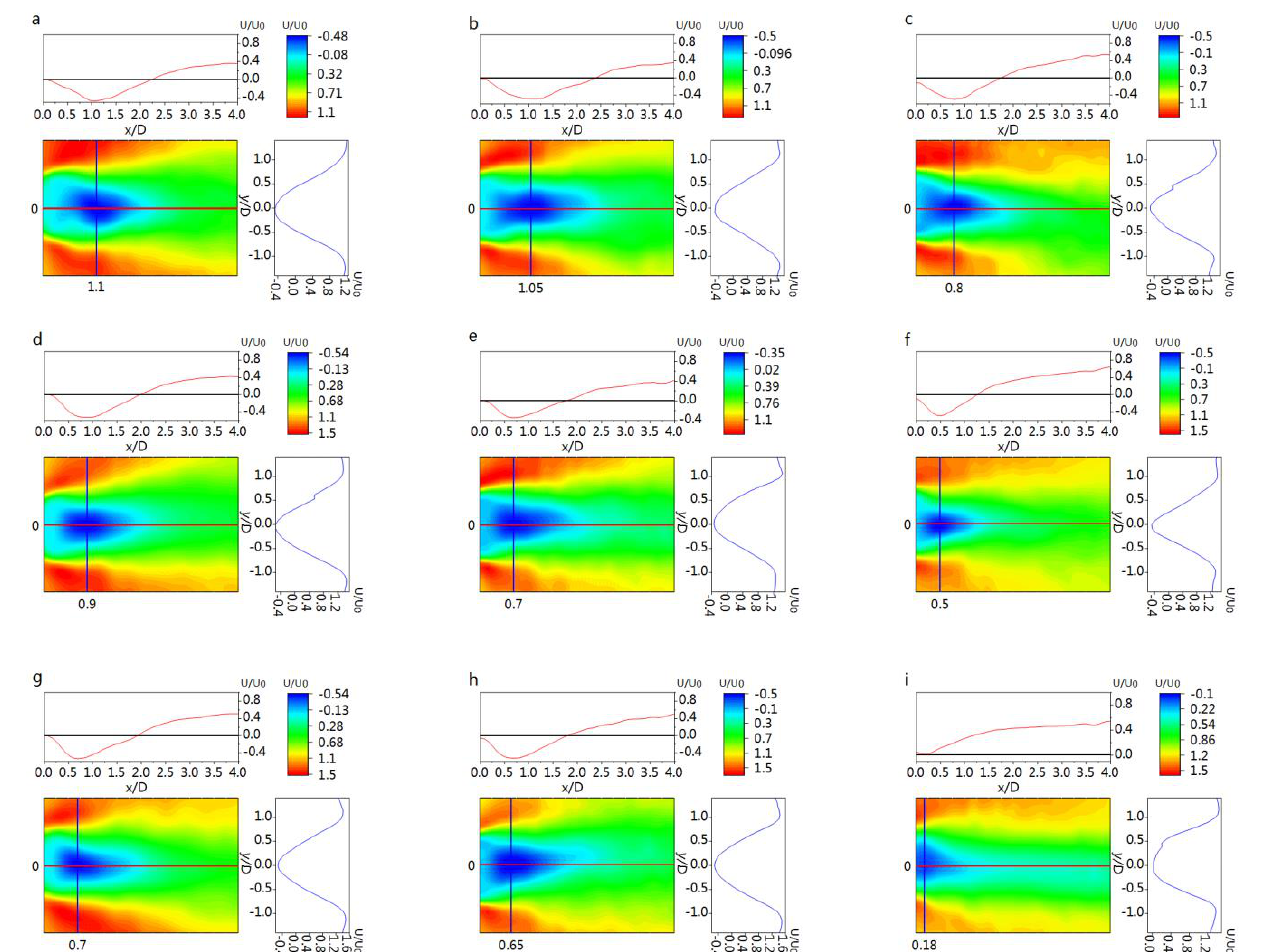
Figure 5. Time-averaged streamwise velocity distribution: ( a ) Ar = 0.2, Re = 1000; ( b ) Ar = 0.3, Re = 1000; ( c ) Ar = 0.5, Re = 1000; ( d ) Ar = 0.2, Re = 2000; ( e ) Ar = 0.3, Re = 2000; ( f ) Ar = 0.5, Re = 2000; ( g ) Ar = 0.2, Re = 5000; ( h ) Ar = 0.3, Re = 5000; ( i ) Ar = 0.5, Re = 5000.